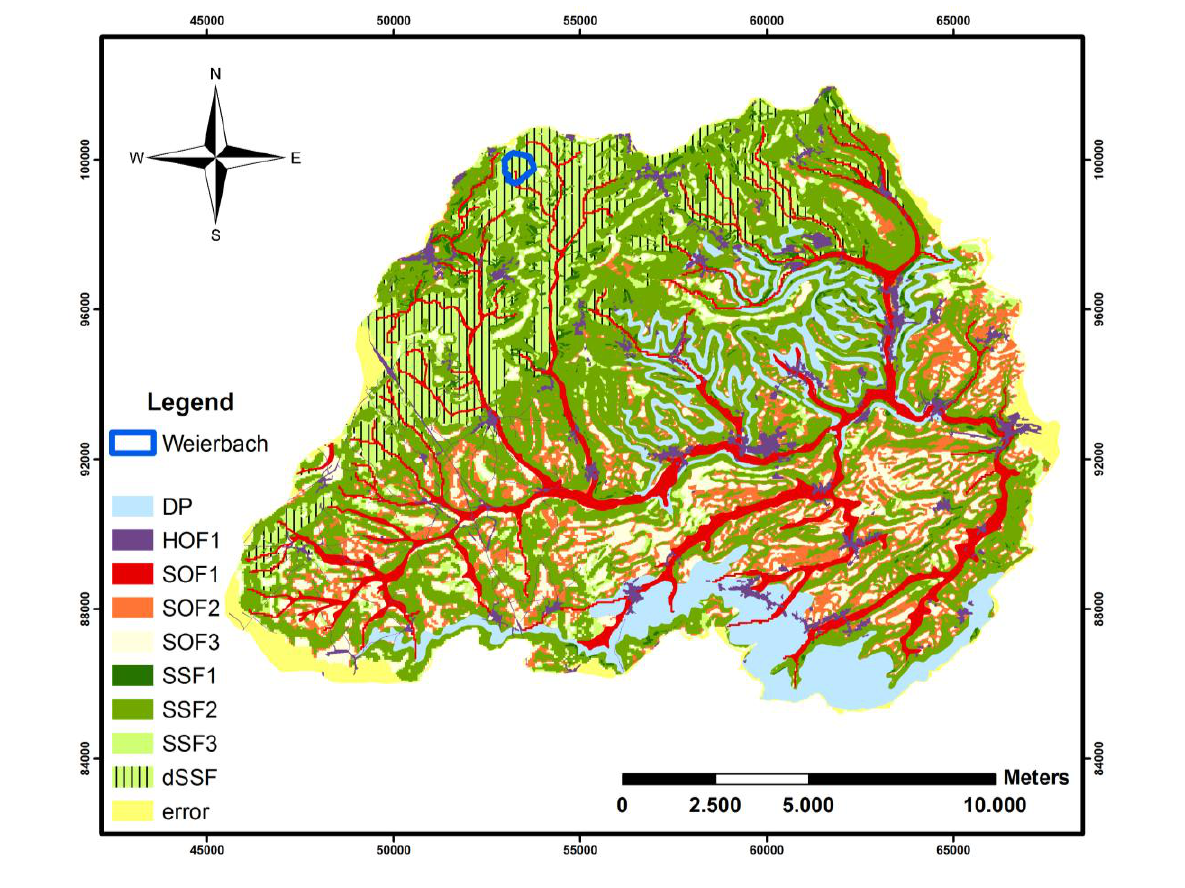
Figure 13. GIS-DRP-map Attert semipermeability (error = lack in basic